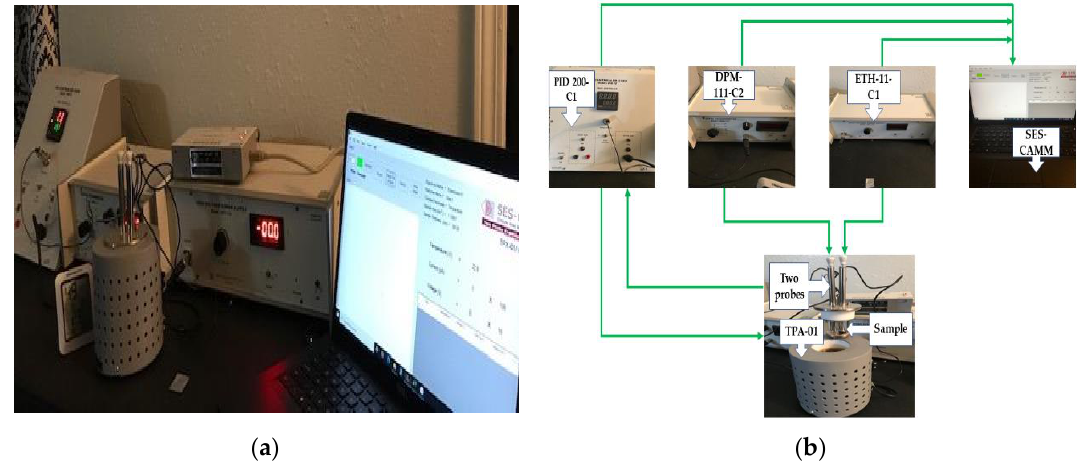
Figure 1. Resistivity measurement setup 1 (TPX-200 C). ( a ) Overall setup, ( b ) block diagram of connections.